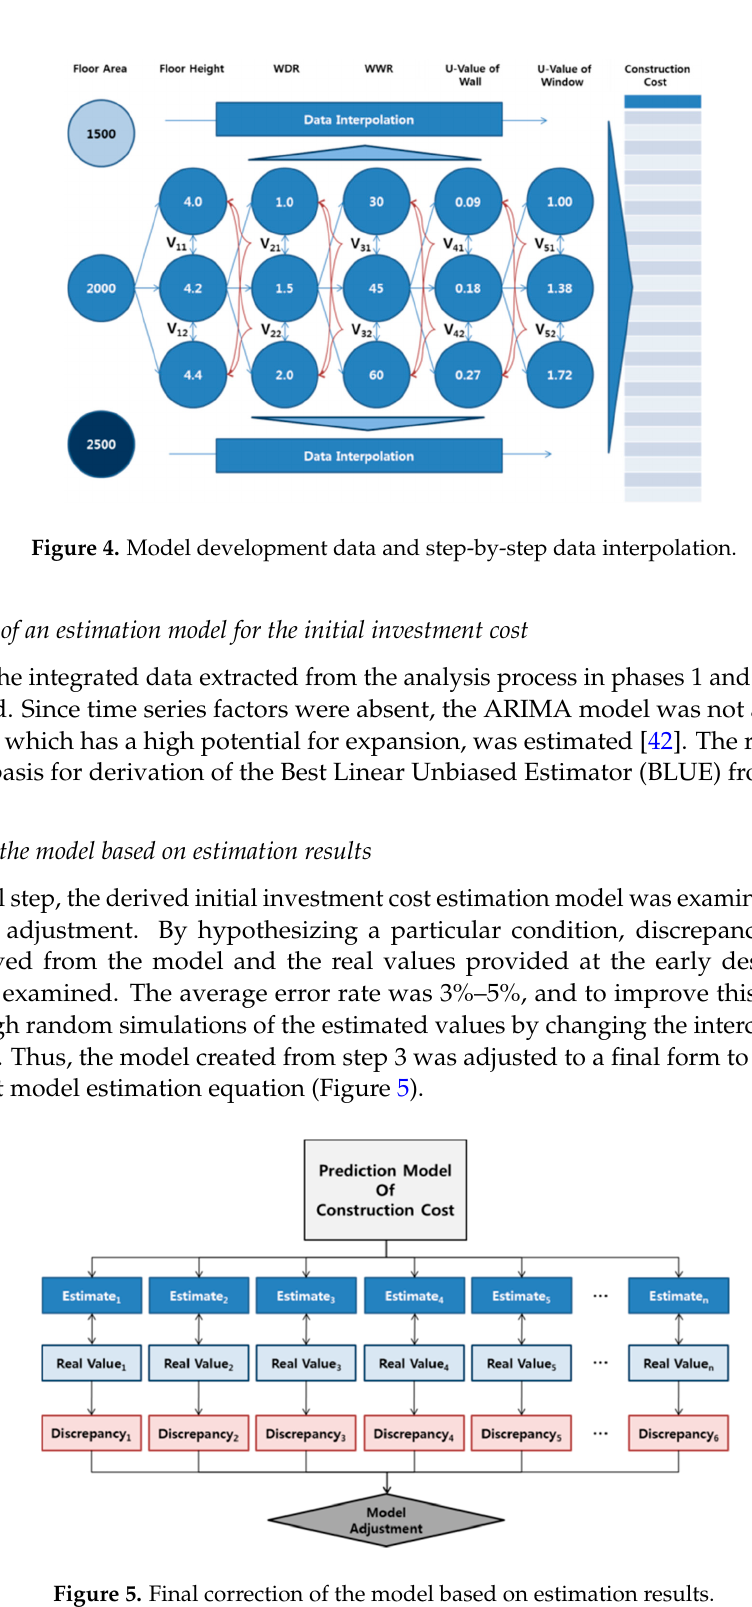
12 of 22 Figure 3. First-order model estimation process based on volatility. -